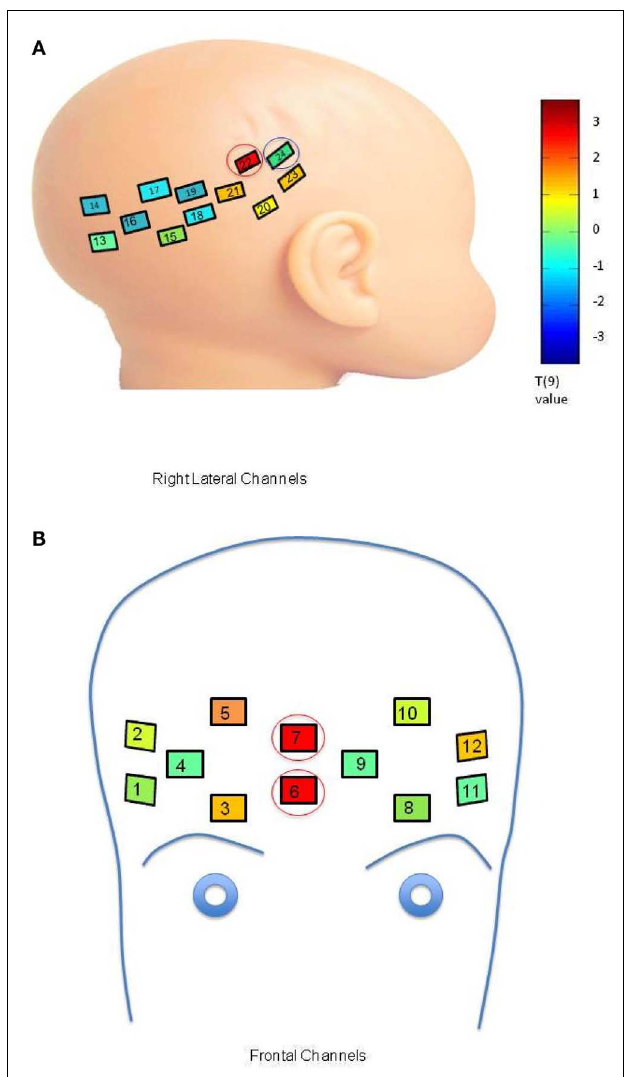
FIGUREA1 | (A) Comparison of response to neutral mother and neutral stranger faces within the LRC group. Channel placement and numbers are shown on the right lateral portions of the infant head. Colors within the channels indicate a T -value map across 10 LRC subjects comparing oxy-hemoglobin response to the neutral mother’s face as compared to the neutral stranger’s face at each channel location (color bar, p = 0.05, Bonferroni corrected).The channel circled in red indicates significant differences in oxy-hemoglobin response, and the channel circled in blue indicates significant differences in deoxy-hemoglobin response. (B) Comparison of Oxy-hemoglobin Response to Smiling Mother and Smiling Stranger Faces within the LRC group. Significant activation occurred in channels placed on the front of the head (numbered as shown). Colors within the channels indicate a T -value map across 10 LRC subjects comparing oxy-hemoglobin response to the smiling mother’s face as compared to the smiling stranger’s face. Channels circled in red indicate significant differences in oxy-hemoglobin